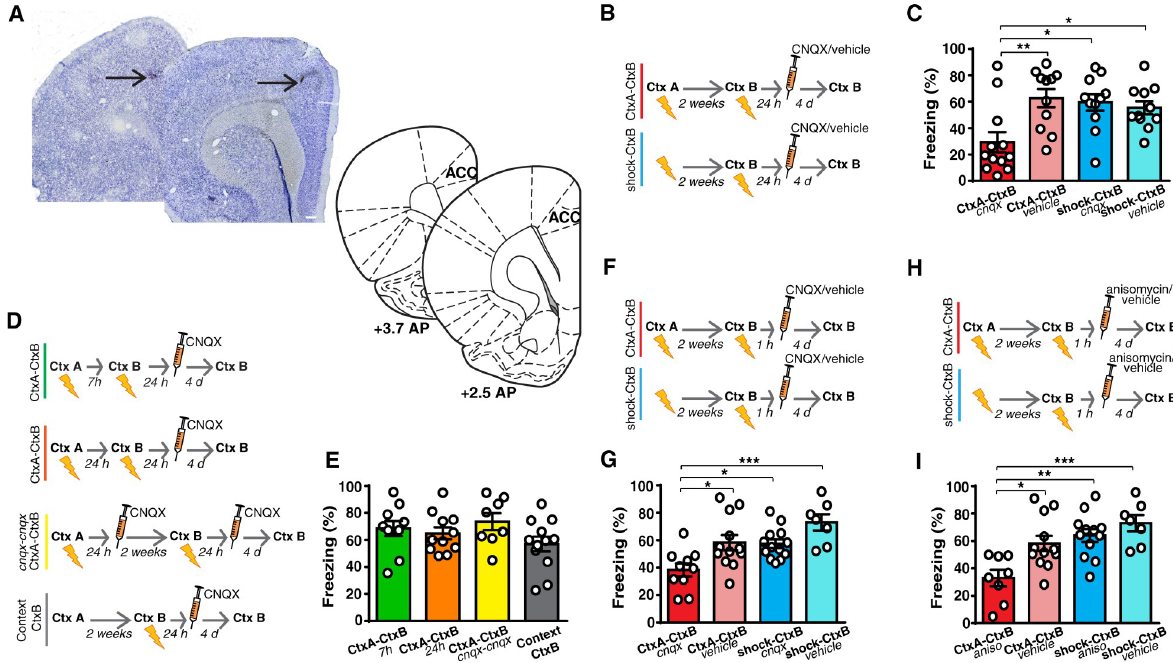
Fig 4. Prior contextual fear learning makes the ACC necessary for the formation of new, recent memories. (A) Example of micrograph of needle track in the ACC. Plates are adapted from Paxinos and Watson [26]. Scale bars, 300 μ m. (B and C) Bilateral CNQX injection in the ACC at 24 h after contextual fear learning impaired the retention of recent memory in rats that have learned a prior association between a different context and the US (CtxA-CtxB, n = 12) as compared to animals that had received only immediate painful stimuli (shock-CtxB, n = 11) or to control rats (CtxA-CtxB, n = 11, shock-CtxB, n = 11) (1-way ANOVA, F (3,41) = 5.612, p = 0.0026, η 2 = 0.291; Tukey: CtxA-CtxB cnqx vs. CtxA-CtxB vehicle , p = 0.0041; CtxA-CtxB cnqx vs. shock-CtxB cnqx , p = 0.0108; CtxA-CtxB cnqx vs. shock-CtxB vehicle , p = 0.0343; other comparisons, p > 0.05). (D and E) The injection of CNQX in the ACC did not affect recent memories in rats where the prior contextual fear learning occurred at 7 h ( n = 10) or 24 h ( n = 11) apart from the new context-US association, in those ( n = 8) where the ACC was blocked 24 h after both the first and the second contextual fear learning events or in those that explored the remote context in the absence of USs (Context-CtxB, n = 12) (1-way ANOVA, F (3,37) = 1.64, p = 0.195, η 2 = 0.117). ( F and G ) Recent memories were also impaired when the injection of CNQX was performed 1 h after learning in the CtxA-CtxB group ( n = 10) as compared to the shock-CtxB group ( n = 13) and to control rats (CtxA-CtxB group, n = 12, shock-CtxB, n = 7) (1-way ANOVA, F (3,38) = 7.32, p = 0.0005, η 2 = 0.3663; Tukey: CtxA-CtxB cnqx vs. CtxA-CtxB vehicle , p = 0.0227; CtxA-CtxB cnqx vs. shock-CtxB cnqx , p = 0.0276; CtxA-CtxB cnqx vs. shock-CtxB vehicle , p = 0.0003; other comparisons, p > 0.05). ( H and I ) Similar results were obtained in rats where protein synthesis was inhibited through anisomycin injection into the ACC (CtxA-CtxB, n = 8; shock-CtxB, n = 12) when compared with the same control groups in Fig 4G (1-way ANOVA, F (3,35) = 7.820, p = 0.0004, η 2 = 0.4013; Tukey: CtxA-CtxB aniso vs. CtxA-CtxB vehicle , p = 0.0146;